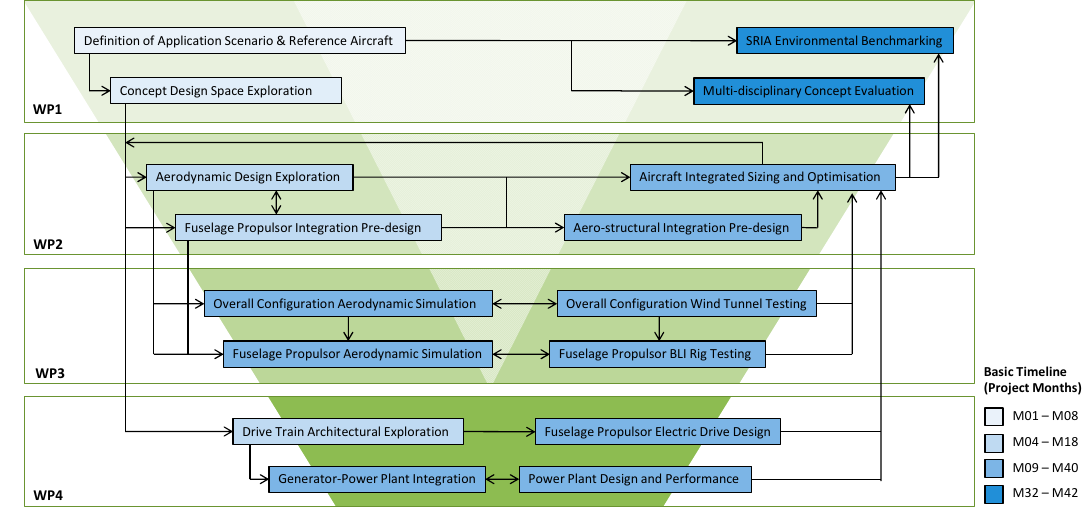
Figure 2. The basic CENTRELINE work logic.